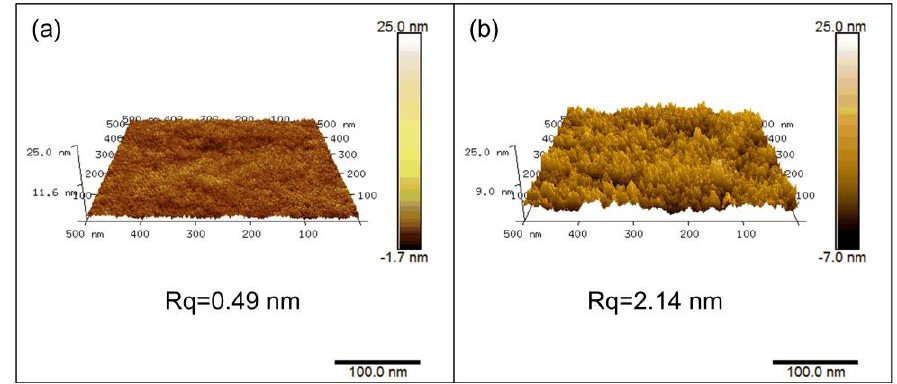
Figure 4. AFM images of solidified coatings from ( a ) As-synthesized pre-polymer sol; ( b ) Sol A.